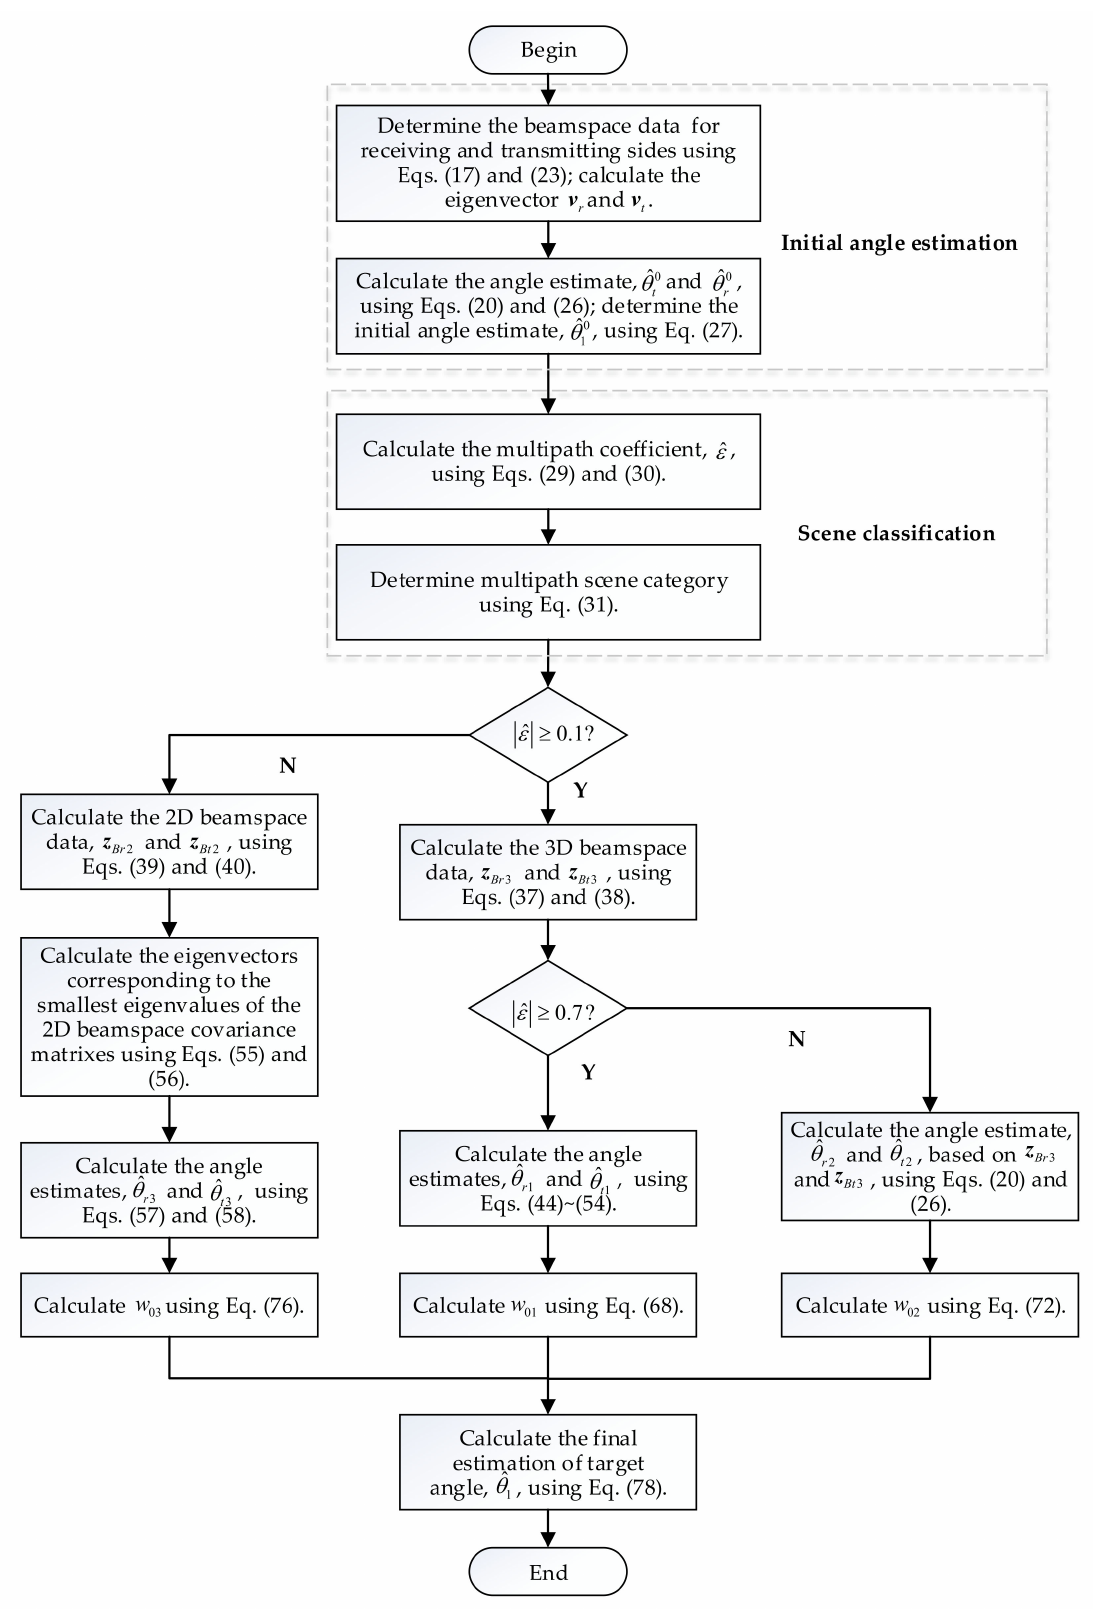
Figure 2. The flow chart of the BSC